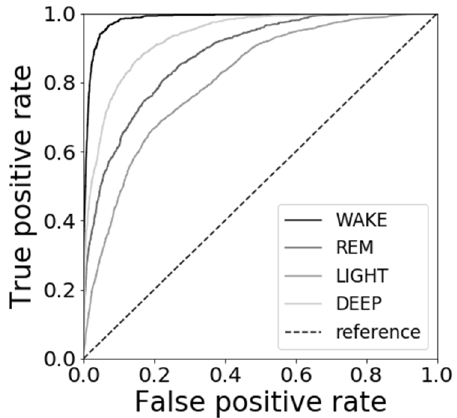
Figure 13. Results of ROC curves.